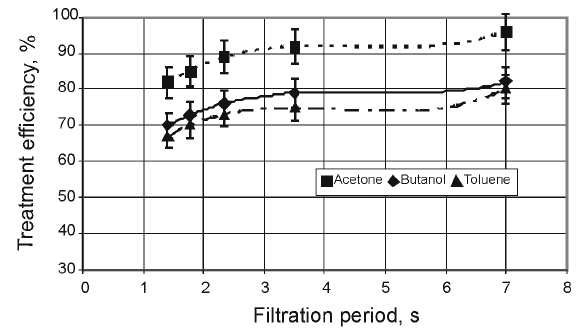
Fig. 8. Dependence of biofilter treatment efficiency on the filtration period when the concentration of the supplied 3 pollutant is 104 ± 5 mg/m